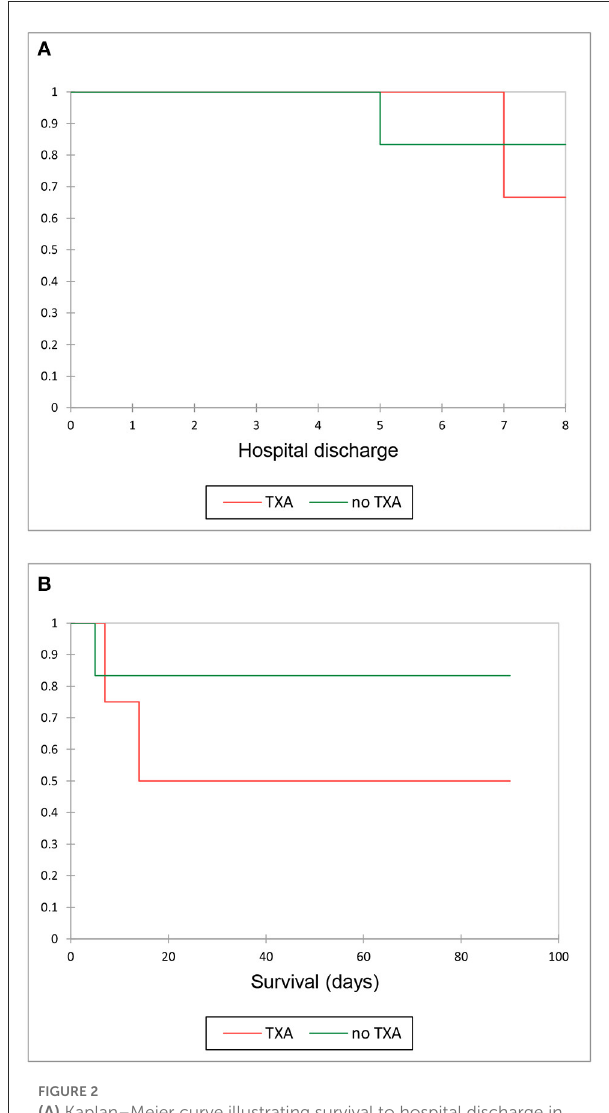
FIGURE2 (A) Kaplan–Meier curve illustrating survival to hospital discharge in the tranexamic acid group (TXA) and control groups. (B) Kaplan– Meier curve illustrating survival 3 months after discharge in the TXA and control